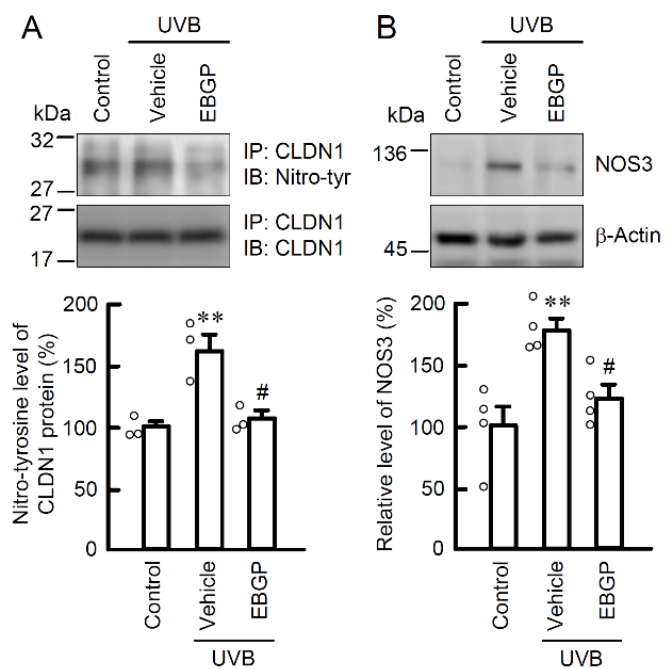
Figure 3. Effect of EBGP on nitratated-CLDN1 and NOS3 expression in the weak UVB-exposed cells. The cells were incubated in the absence (vehicle) and presence of 10 µ g/mL EBGP for 30 min, followed by exposure to 5 mJ/cm 2 UVB for 6 h. ( A ) The cell lysates were immunoprecipitated with anti-CLDN1 antibody. The immunoprecipitants were applied to SDS-PAGE and detected using anti-tyrosine nitration (nitro-tyr) and anti-CLDN1 antibodies. The levels of tyrosine nitration of CLDN1 were represented as a percentage of control. n = 3–4. ** p < 0.01 vs. control. # p < 0.05 vs. vehicle. ( B ) The cell lysates were applied to SDS-PAGE and detected using anti-NOS3 and anti- β -actin antibodies. β -actin was used as a loading control. The levels of NOS3 expression were represented as a percentage of control. n = 4. ** p < 0.01 vs. control. # p < 0.05 vs. vehicle.